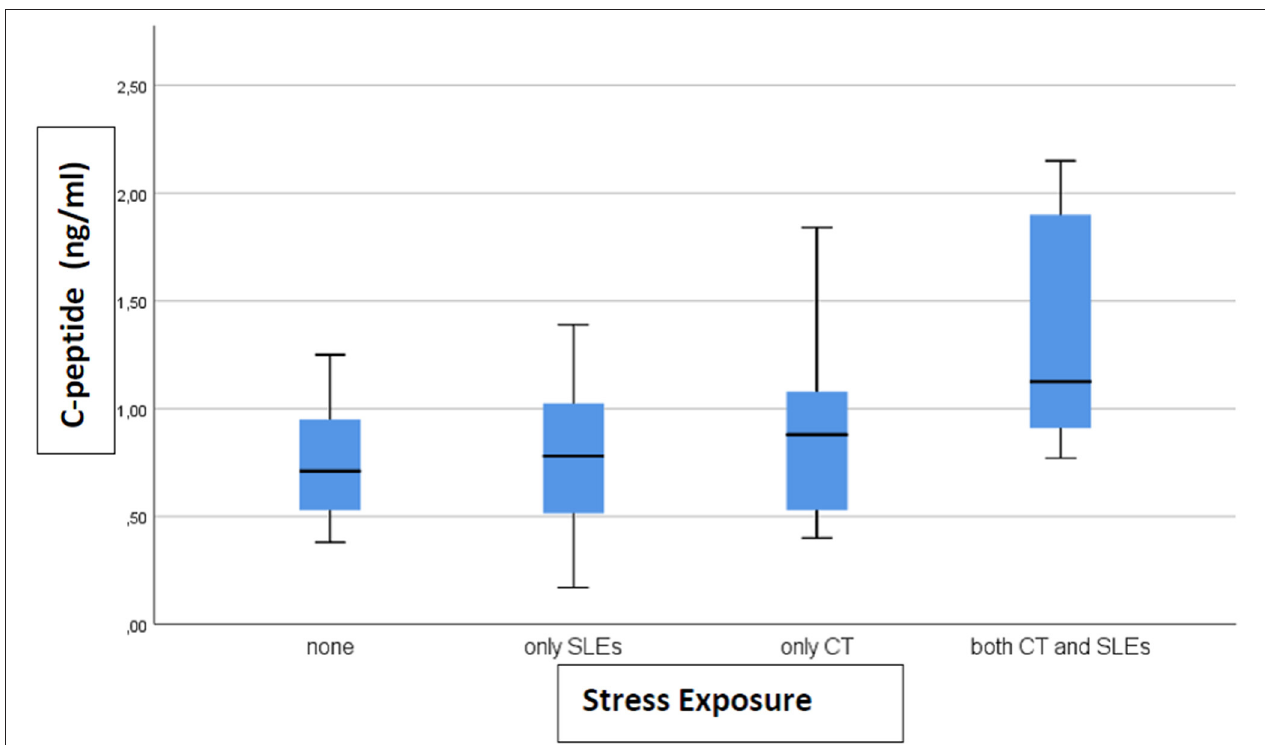
FIGURE 1 | The box-plot for c-peptide serum concentration distribution in subjects who experienced different exposure to childhood trauma (CT) and severe stressful life events (SLEs) ( n = 72).